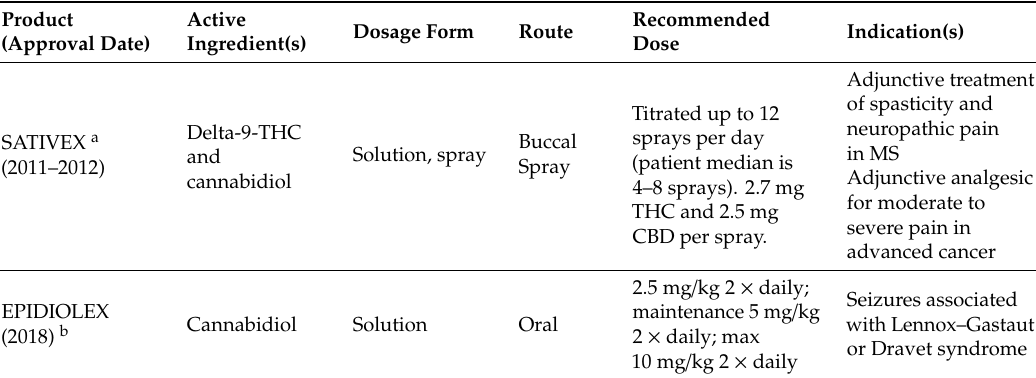
Table 1. Product information for cannabis-derived pharmaceutical